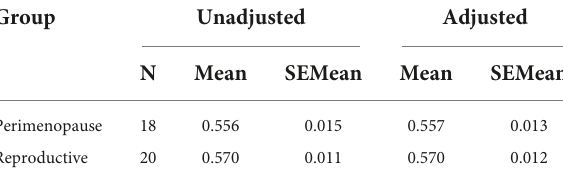
TABLE 4 Unadjusted and covariate adjusted descriptive statistics for LDLPFC Glu/Cr+PCr. Group